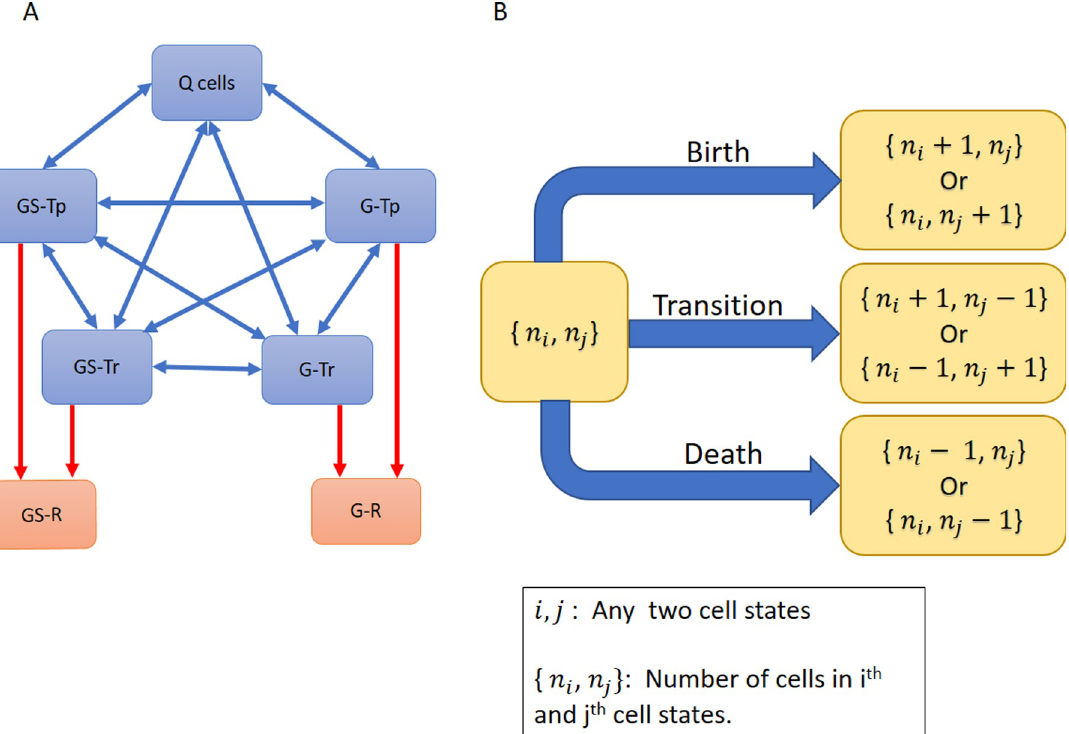
Fig 1. Schematic of the basic single-step cell state model. (A) The model consists of five states: Quiescent cells (Q), transcriptionally- permissive Glioma and Glioma Stem cells (G-Tp and GS-Tp, respectively), and transcriptionally-restrictive glioma and glioma stem cells (G-Tr and GS-Tr, respectively). Cells can transition between any two of these states (indicated by two-sided blue arrows). In addition, in the presence of drug therapy, cells may transition to drug resistant states (G-R/GS-R). Once in a resistant cell state, the cells are unable to transition back to drug-sensitive states (indicated by one-way red arrows). (B) Cells can undergo birth (except Q cells), death or transition to another state.